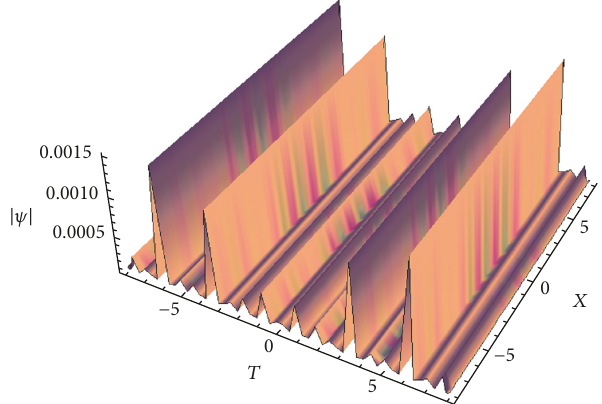
Figure 17: Spatial structure of the module of solution (81) with 𝑘 = 10000